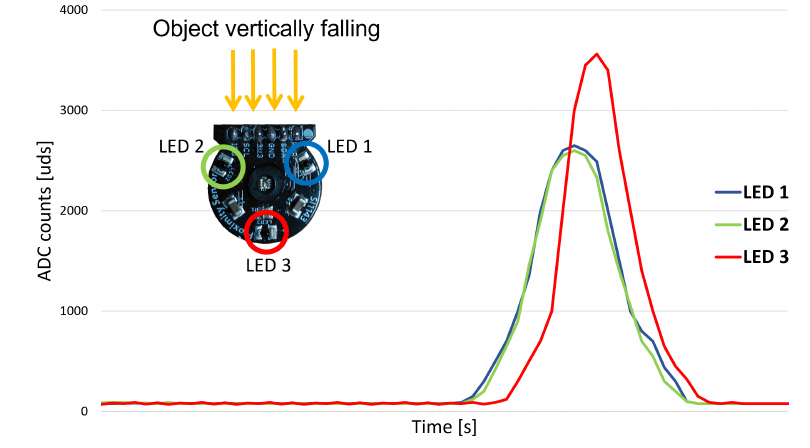
Figure 7. ADC readings from SI1143 sensor when a cube